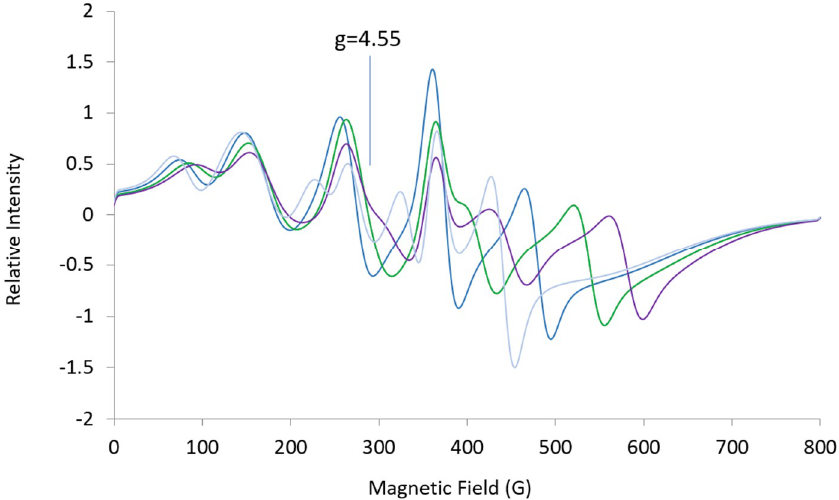
Figure 5. Simulated L-band (1.37 GHz) spectra: A = [369, 508, 100], g eff = [4.96, 4.55, 1.94], HStrain = [150, 150, 600] (blue); g -mid = 4.04 (green), 3.75 (purple), 4.96 (light blue). Changes imply that two high-field lines are sensitive to g -mid.